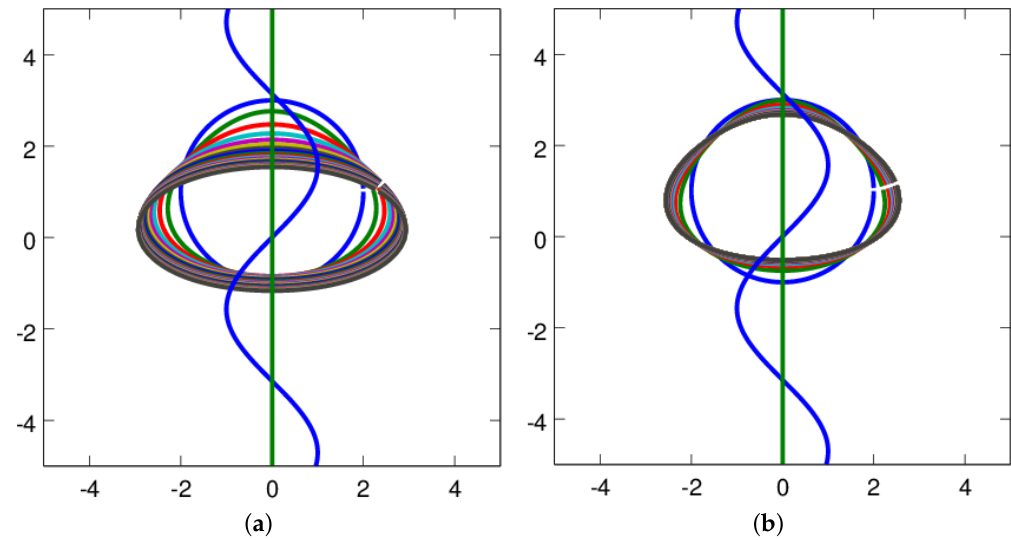
Figure 4. Depiction of the evolution from a circular patch with ( a ) SA vs. ( b ) DBSA. Initially the patch is off axis (the y value being where the background flow U is antisymmetrical). Whereas SA moves it towards the axis, DBSA tries to find the distorted shape at that center.